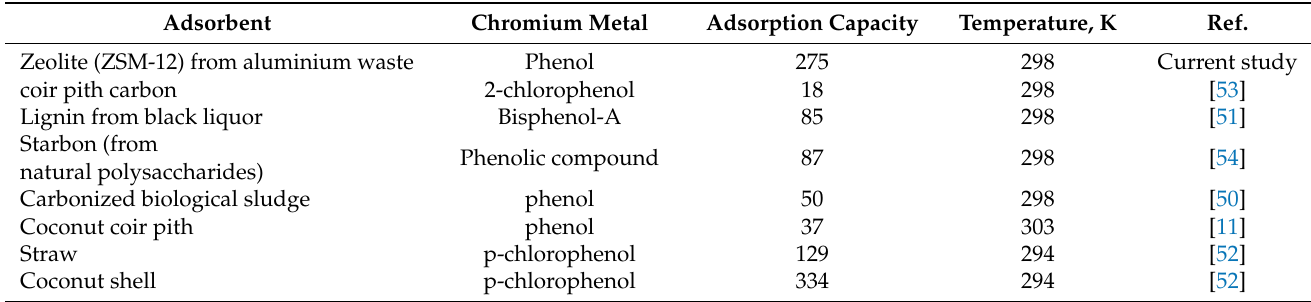
Table 6. Comparison of adsorption capacities of various adsorbents with the current study for phenolic compounds removal.